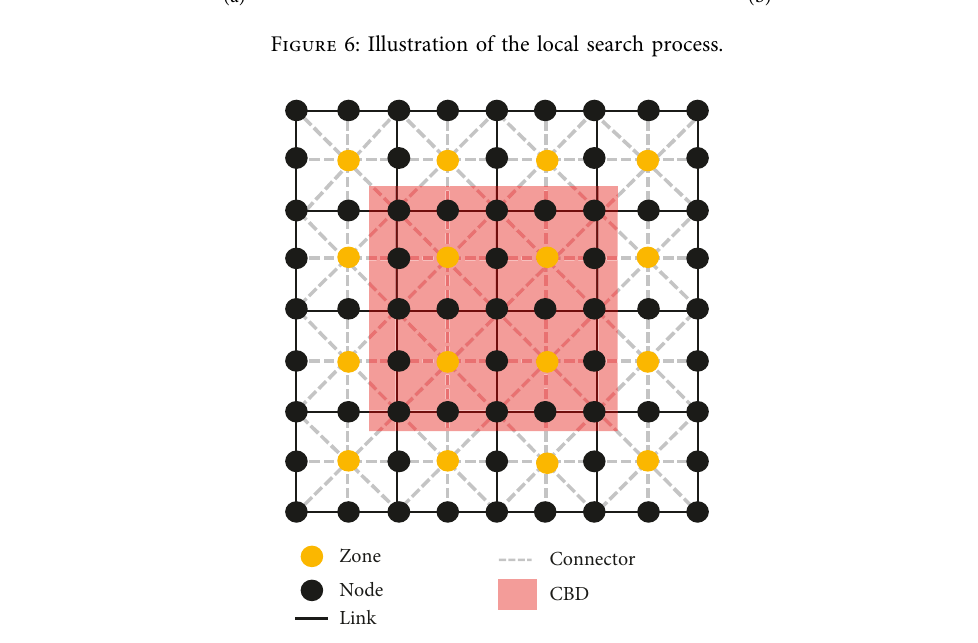
Figure 7: Structure of the toy network.